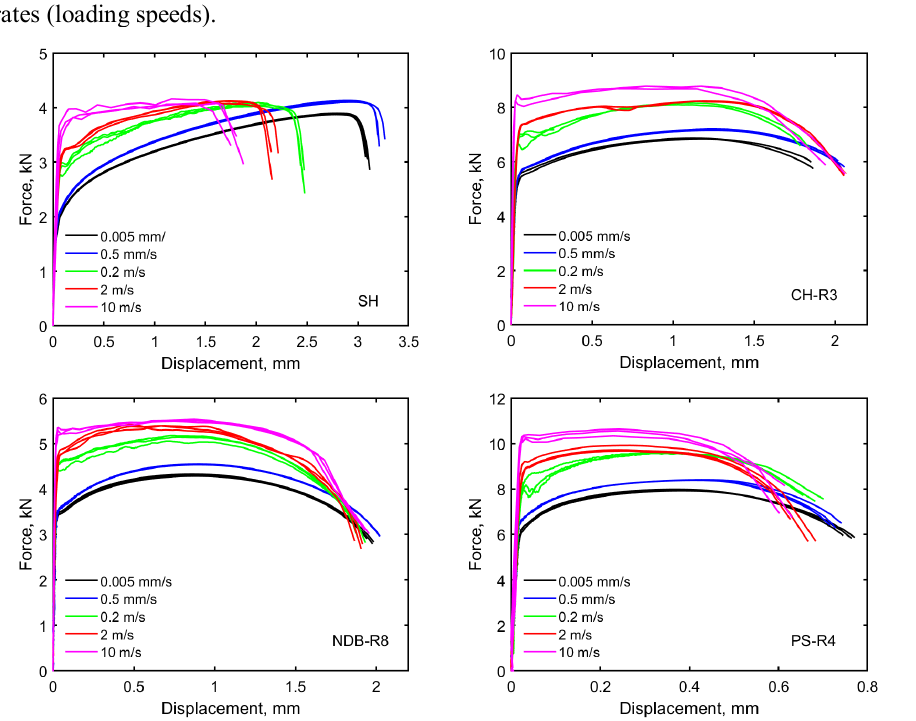
Fig. 8. Force-displacement curves of HX340LAD under different loading speeds for four different specimen